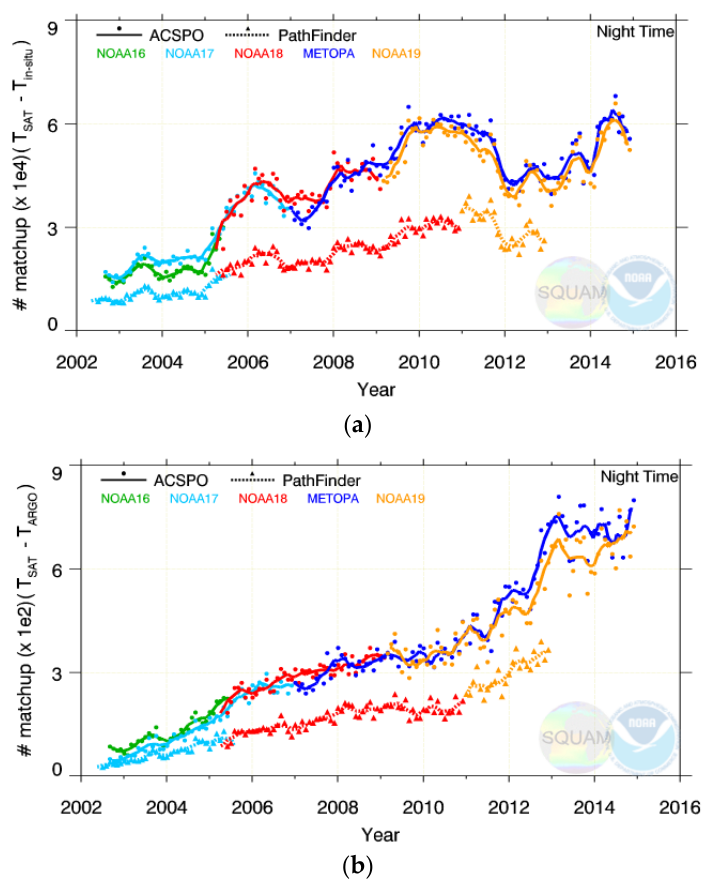
Figure 8. Monthly number of nighttime matchups with: ( a ) drifters/tropical moorings; ( b ) ARGO floats. These matchups were used for producing Figures 9 and 10 below.